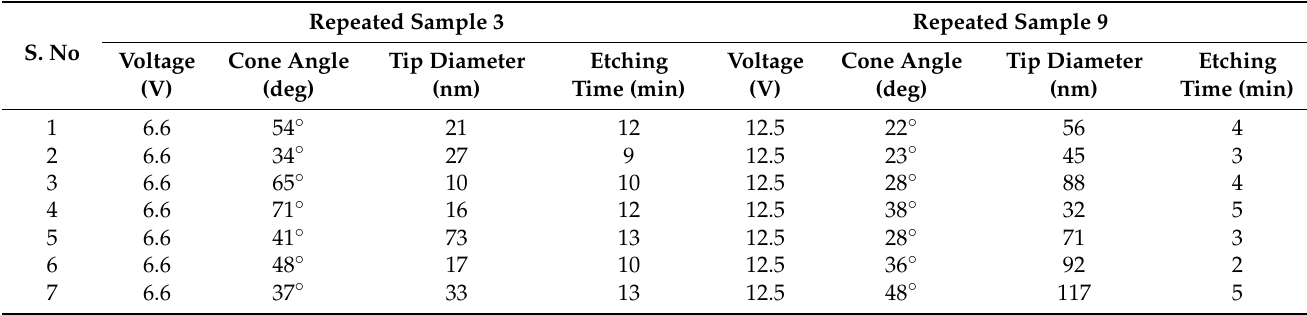
Table 2. Experimental results for 0.4 mm tips showing optimized results of Sample 3 and 9 in 2 M NaOH solution on AC